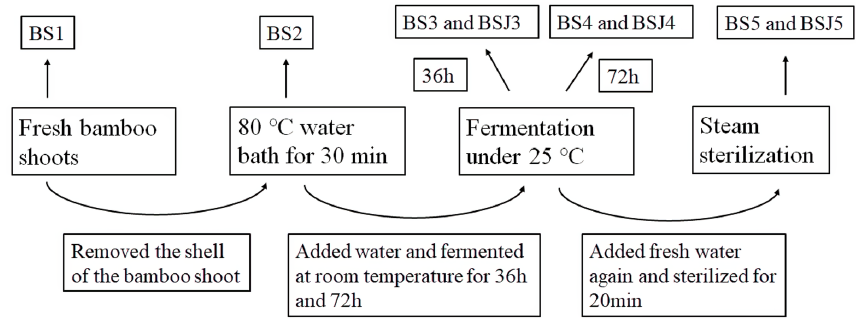
Figure 1. Processing flow chart of canned bamboo shoots in clear water.